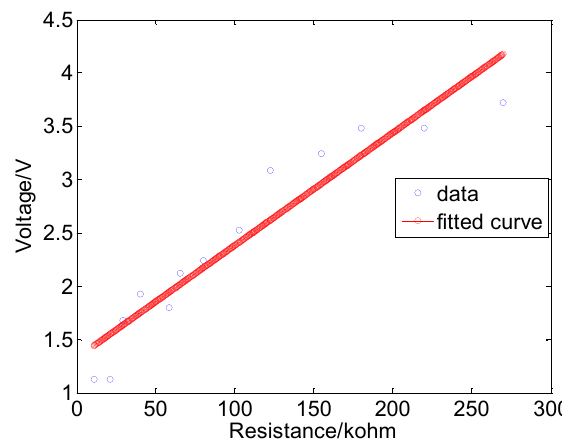
Figure 8: Plot showing the output voltage across varying load